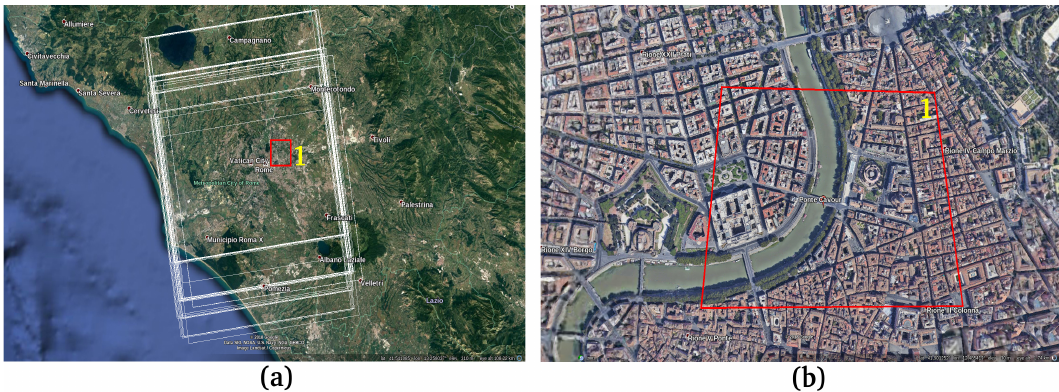
Figure 7. Case study 3 optical representations. ( a ): georeferenced footprints of the SAR long temporal series. ( b ): ROI footprint.